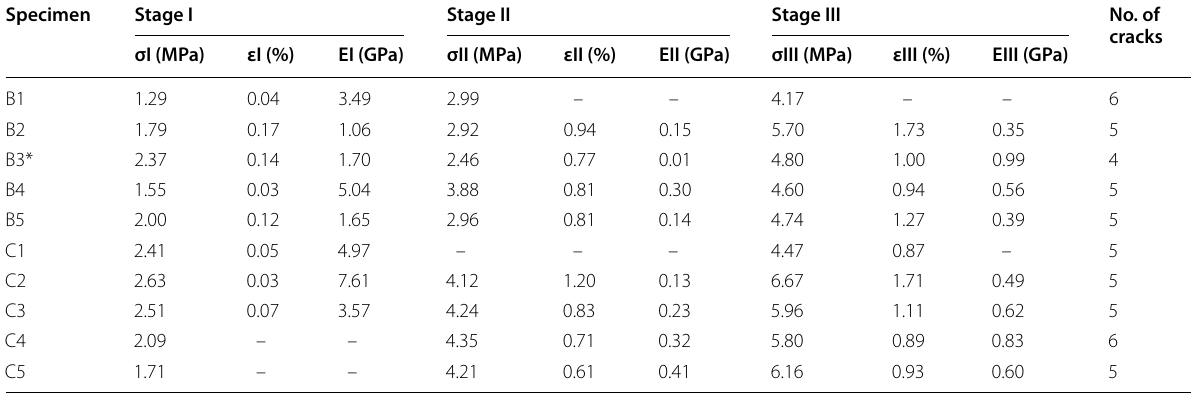
Table 2 Results of tensile bond